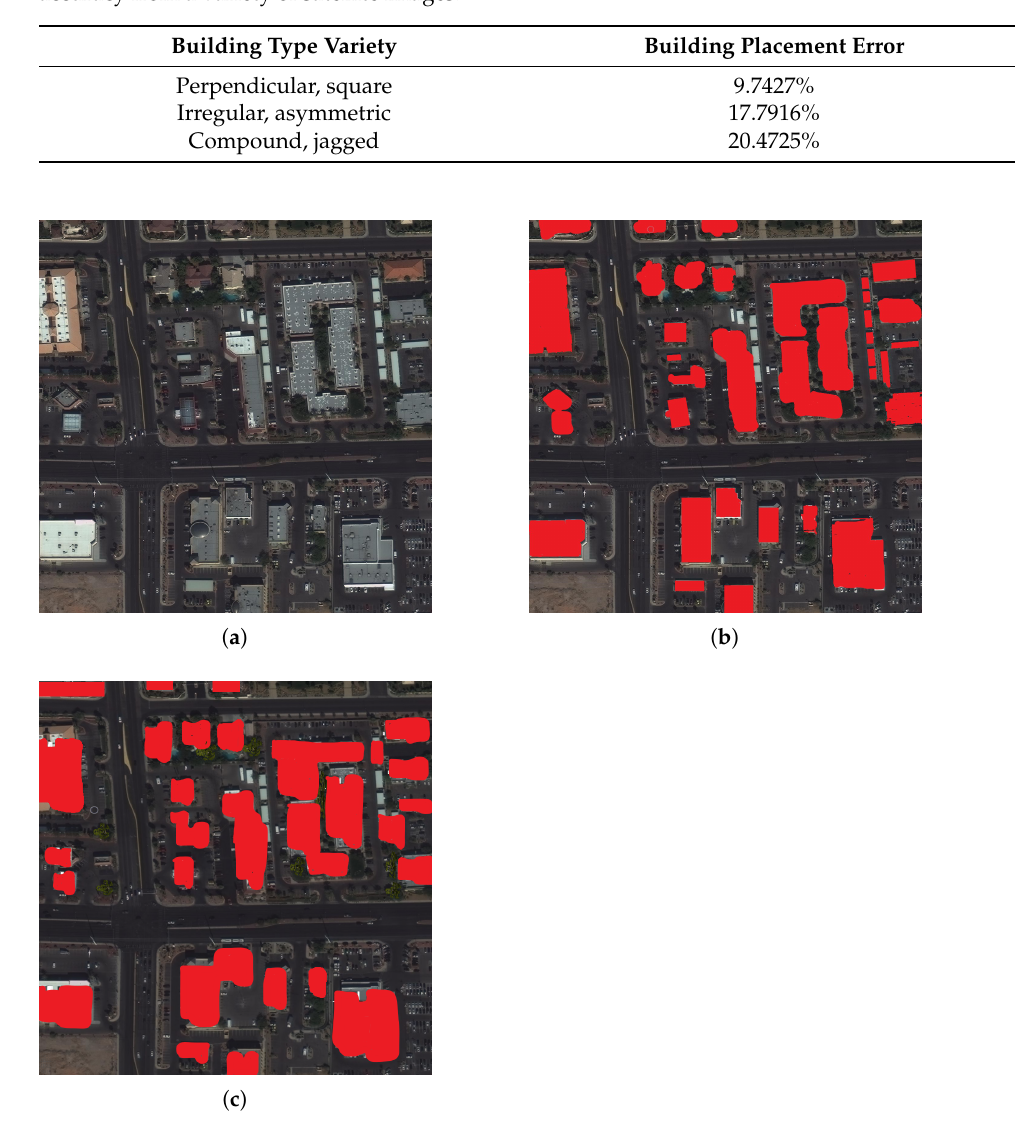
Table 4. Quantitative validation framework. Validation summary for Gazebo model placement accuracy from a variety of satellite images.